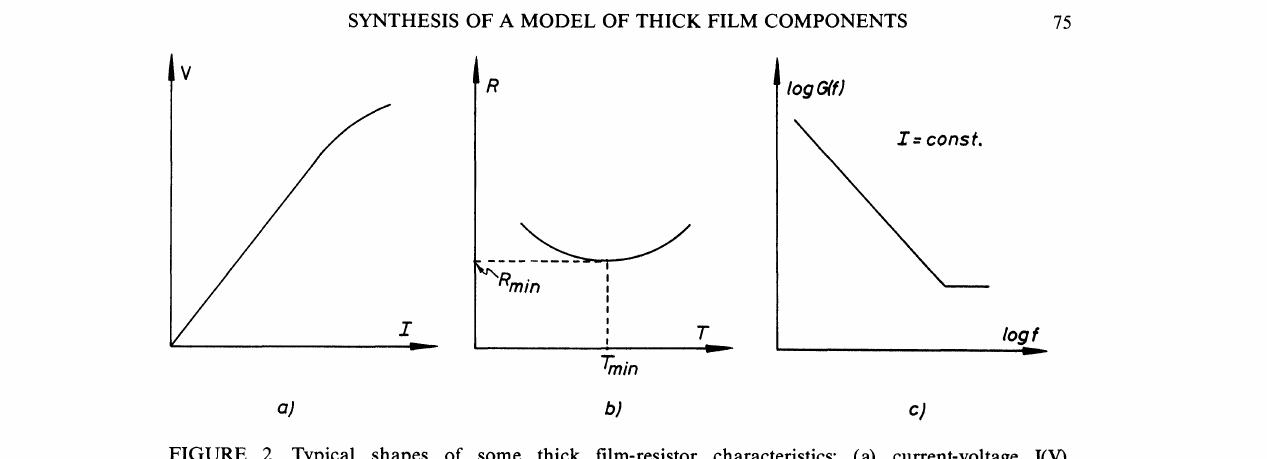
FIGURE 2 Typical shapes of some thick film-resistor characteristics: (a) current-voltage I(V), (b) temperature R(T), (c) noise density